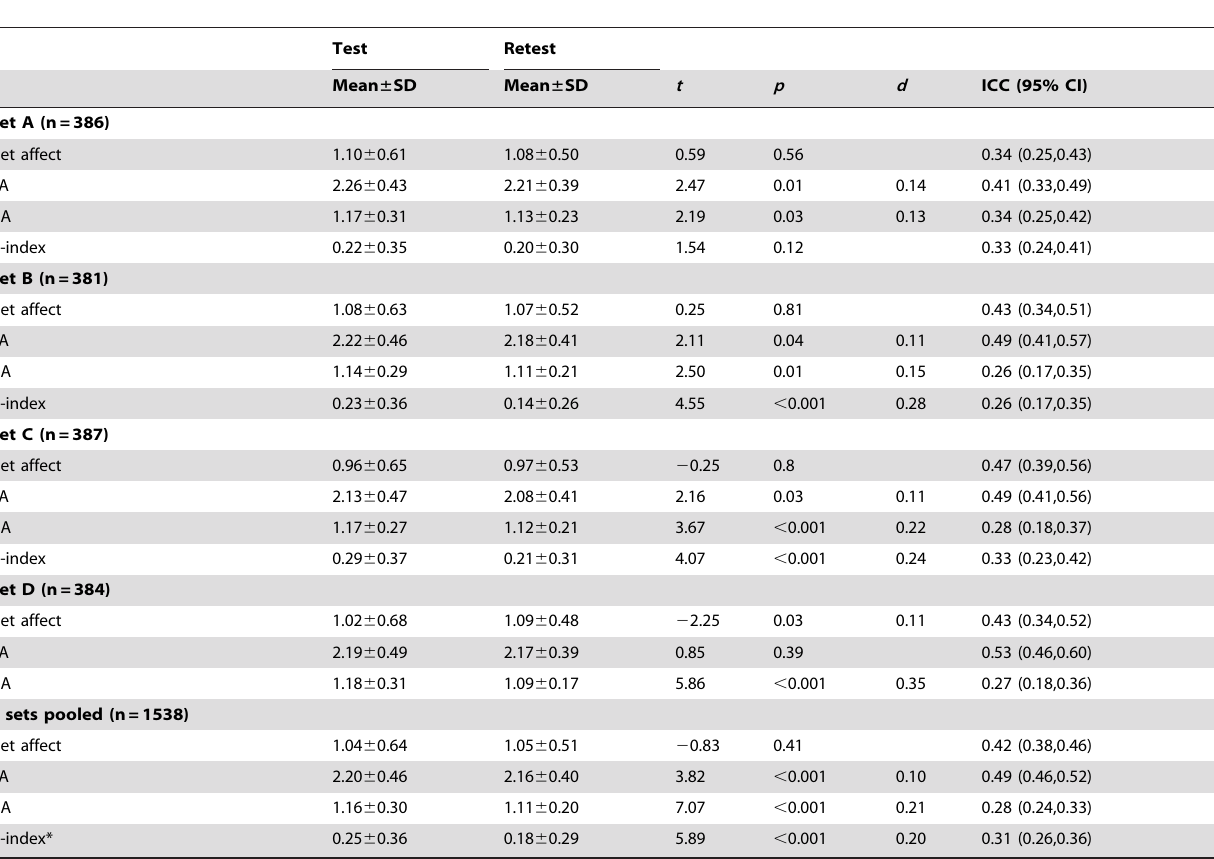
Table 2. Mean 6 SD of affect measures for each set and overall in the test and the retest. p -values associated to paired t -tests and ICC